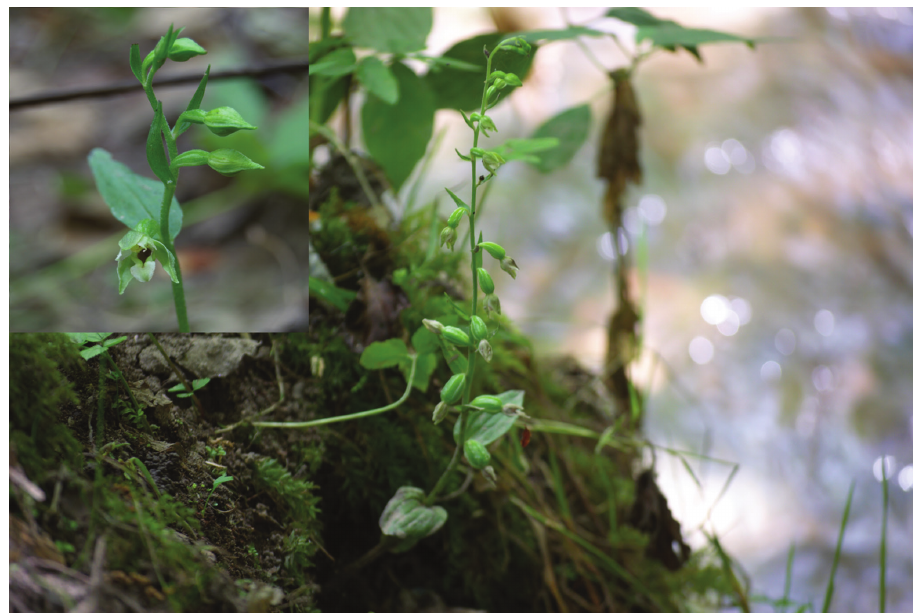
Figure 1. Epipactis maricae at the locus classicus on the Savone delle Ferriere stream, near the village of Furnolo (Teano, Caserta). Pictures by A. Croce.